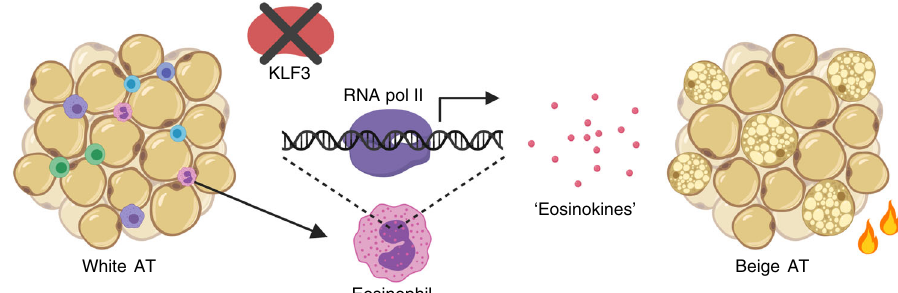
Fig. 6 KLF3 regulation of eosinophil gene expression and function in adipose tissue. Proposed model by which KLF3 may regulate the expression of eosinophil-derived factors in the conversion from white to beige